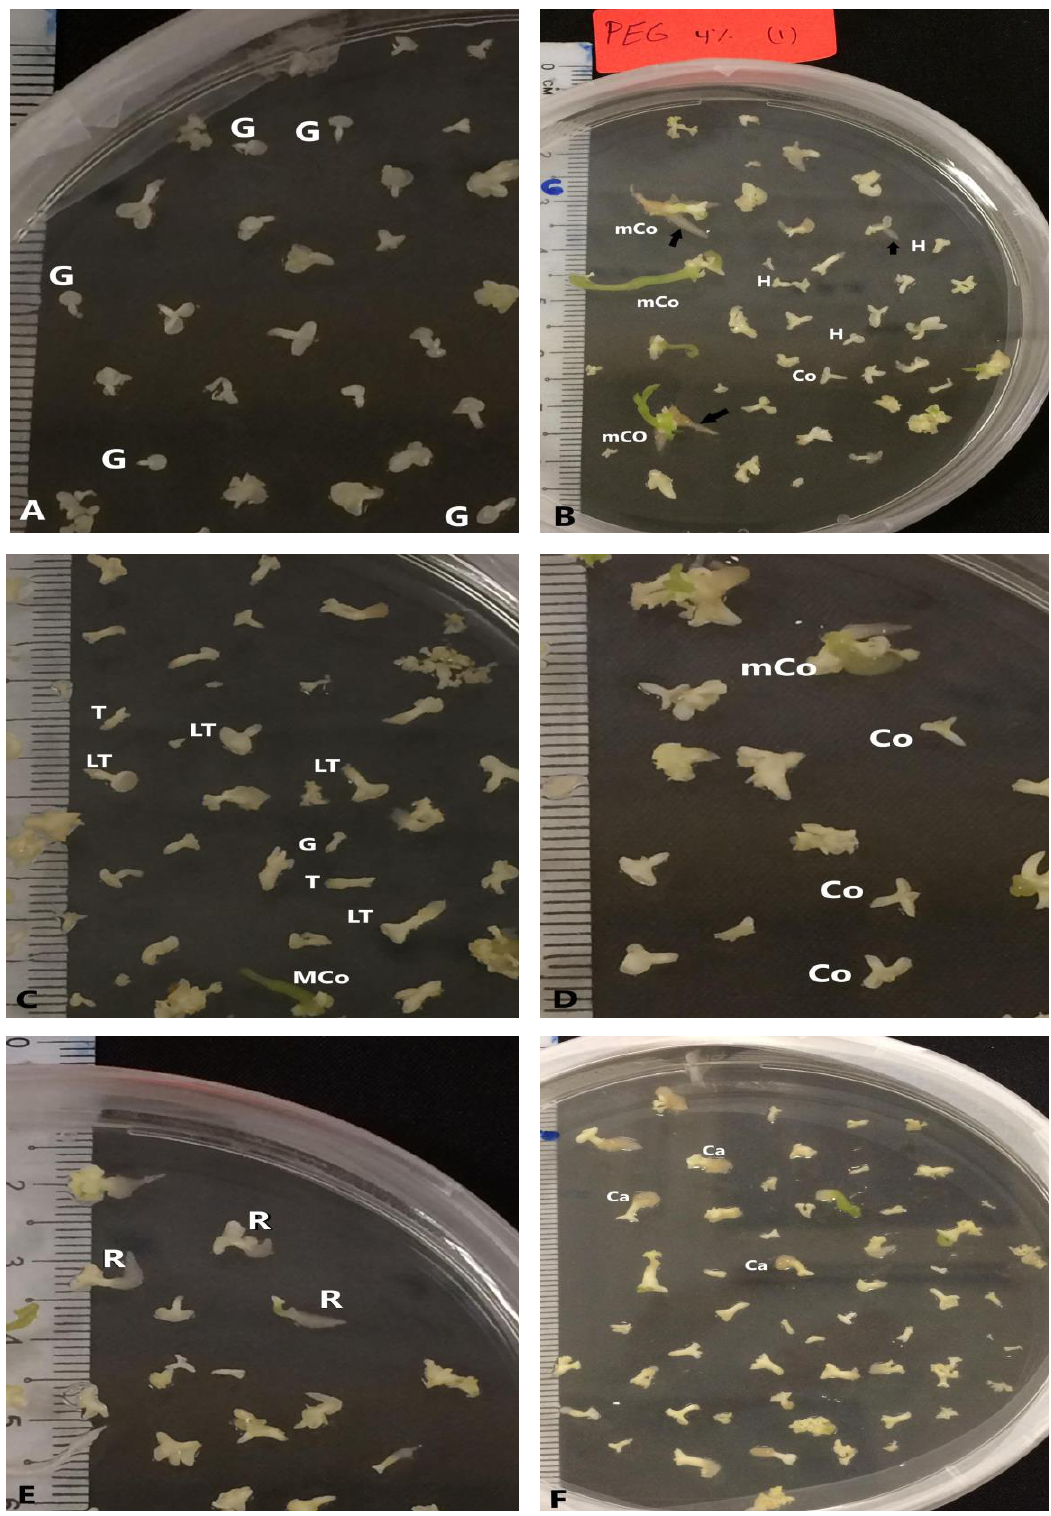
Figure 4. Different developmental stages of somatic embryos during maturation phase: ( A ) globular shape (G) of somatic embryo, ( B ) heart shape (H) and mature cotyledon stage (MCo) of somatic embryo, ( C ) torpedo stage (T), late torpedo stage (LT) and mature cotyledon stage (MCo) of somatic embryos, ( D ) cotyledon stage (Co) and mature cotyledon stage (MCo) of somatic embryos, ( E ) somatic embryos with root (R), ( F ) somatic embryos with callus (Ca) at the base end.